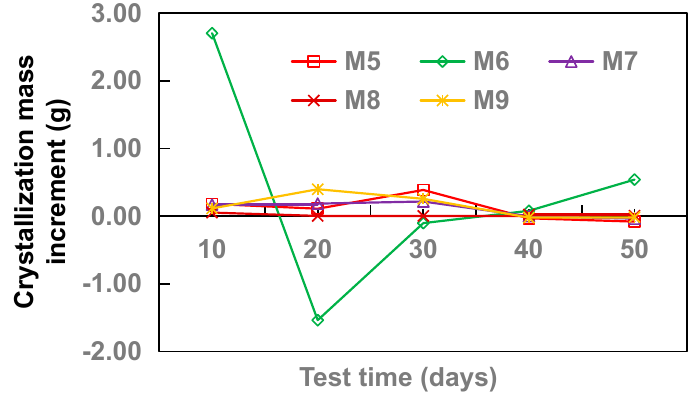
Figure 12. Variation of crystal mass increment with time.